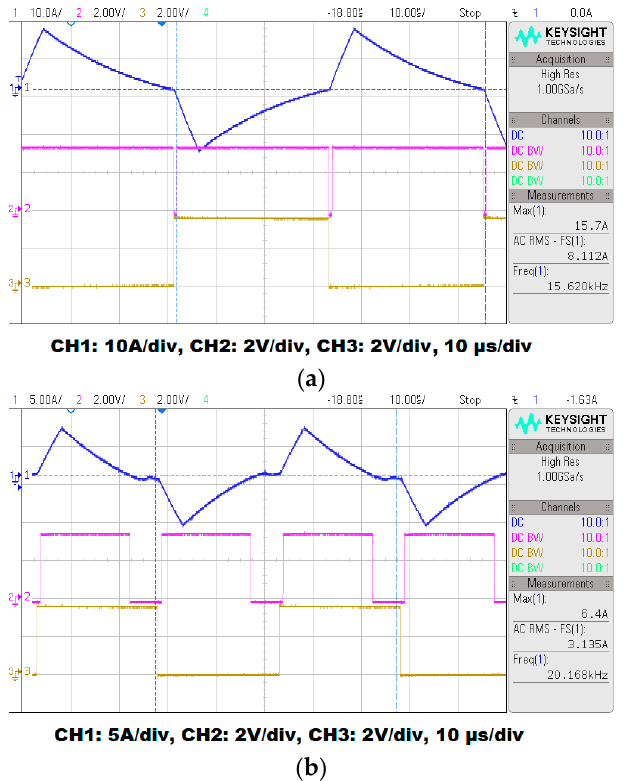
Figure 15. The current in the primary winding circuit (CH1), the signal from the comparator detect- ing the zero current in the primary circuit (CH2) and the signal controlling one of the transistor on the high side HS (CH3) in a situation where the current fades in a time greater than the minimum switching time of the transistors—measurement performed in the initial charging phase ( a ) and in a situation where the current fades in a time less than the minimum turn-on time of the transistors— measurement performed in the final phase of charging ( b ).